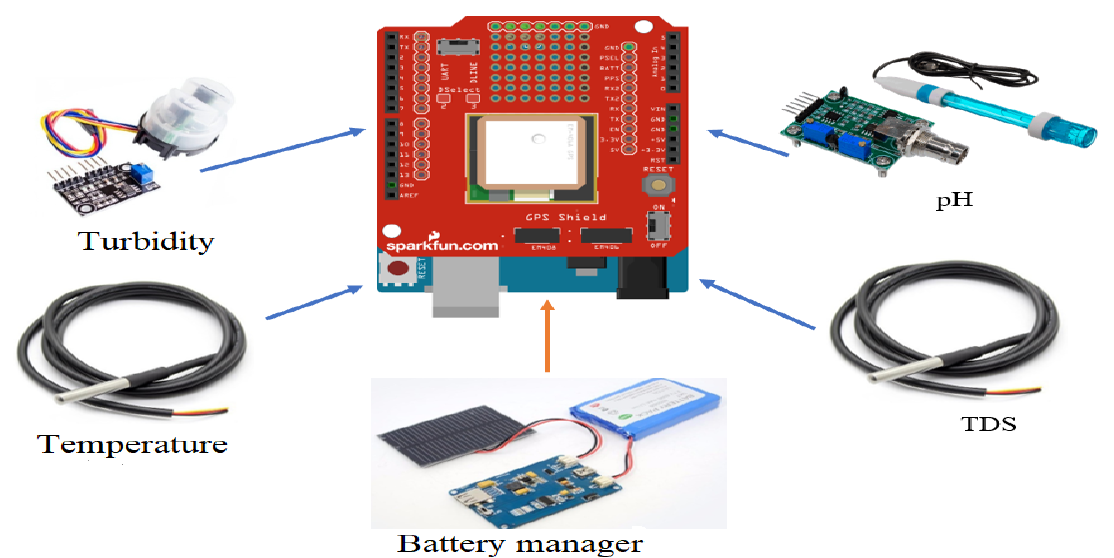
Figure 2. Demonstrative diagram of the proposed WSN system. Considered sensors ( SKU: SENO189 (turbidity), SKU: PH-7BNC (pH), Ds18b20 (temperature), RB-Dfr-797 (TDS)), and the processor ( Arduino Uno